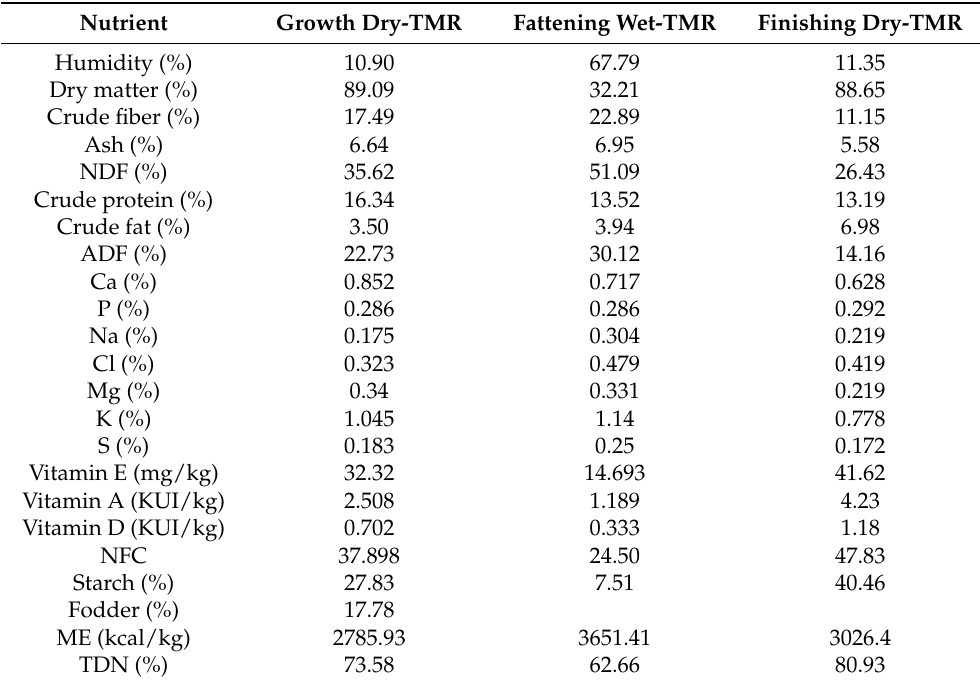
Table 2. Diet composition (percentage of dry matter) given to all steers in the study during the growth and fattening